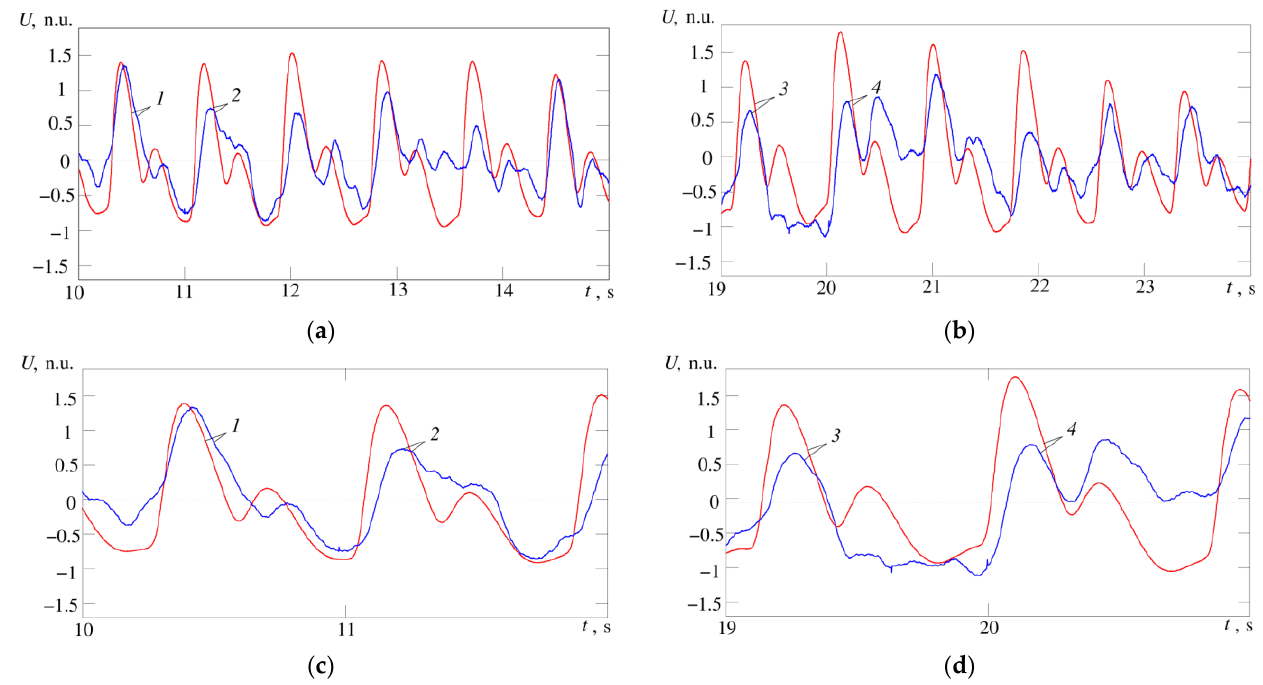
Figure 13. Fragments of the recorded temperature signal (blue curve) and pulse wave (red curve); ( a ) records for subject A; ( b ) records for subject B; ( c , d ) the same waveforms on a larger scale for subject A and B, respectively; 1–4 are the maximum cusps of the compared cardiac cycles by the temperature and pulse wave signals. The correlation is 0.65 ( a ) and 0.54 ( b ), ( p < 0.05). Signal amplitude values are normalized, n.u.—normalized units.